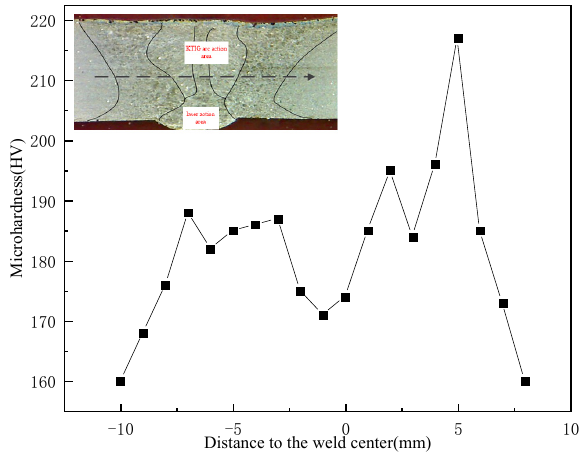
Figure 13. Microhardness profile on cross-sections of weld joints. Tensile specimens were made from hybrid welding seams obtained under different arc currents, heat source distance, welding speed, laser power, and defocusing amount. A total of 44 tensile specimens were obtained. Some samples were selected for the tensile test. The fractures are all located at the base metal position. To measure its actual mechanical properties, a total of 23 tensile specimens were obtained after thinning the middle position of the remaining tensile specimens. Then the tensile test was carried out, and the results were described in Figure 14.